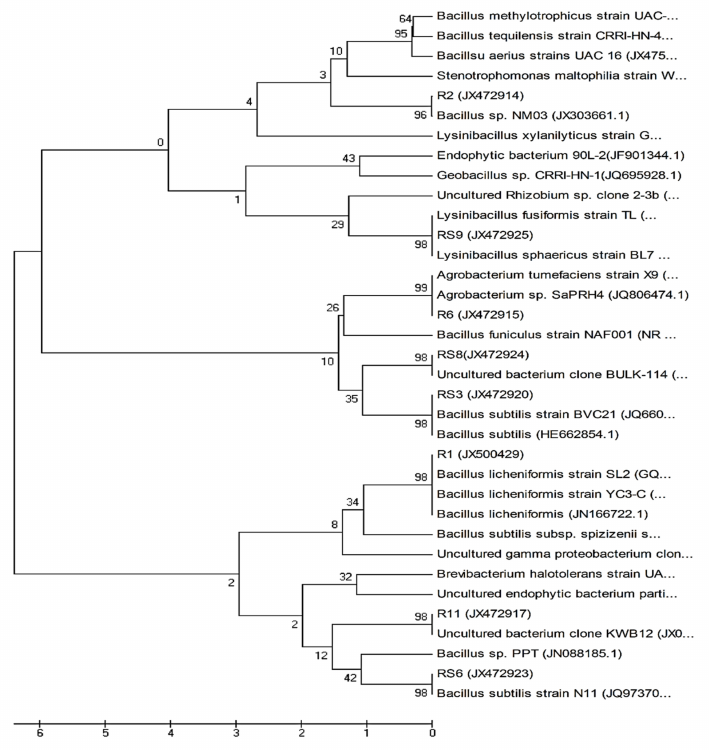
Figure 1. The phylogenetic tree of isolated endophytic bacterial strains was constructed using the neighbor-joining method by MEGA 5 software. Each number on a branch indicates the bootstrap confidence values corresponding to the scale bar of branch